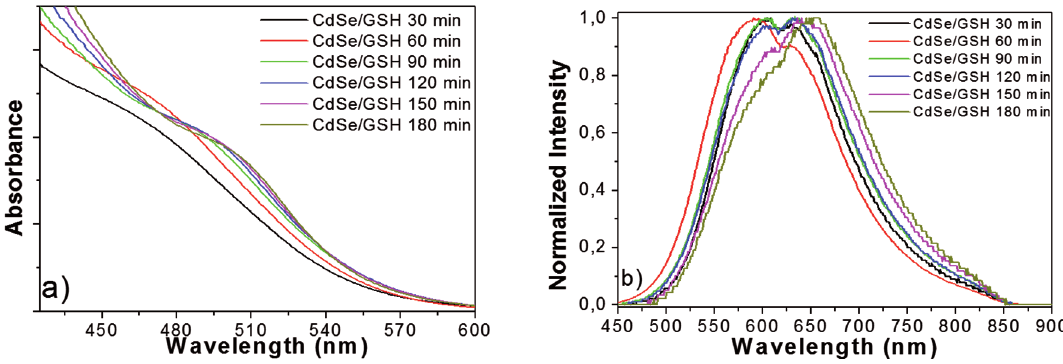
due to C-O stretching. In contrast, the spectra of the capped CdSe samples displayed the symmetric and asymmetric absorption bands assigned to the carboxylate anion of the surface ligands. The existence of the carboxylate anion in the QDs resulted from the synthesis process, which used NaOH to adjust the pH to 10.0 and therefore deprotonated the COOH